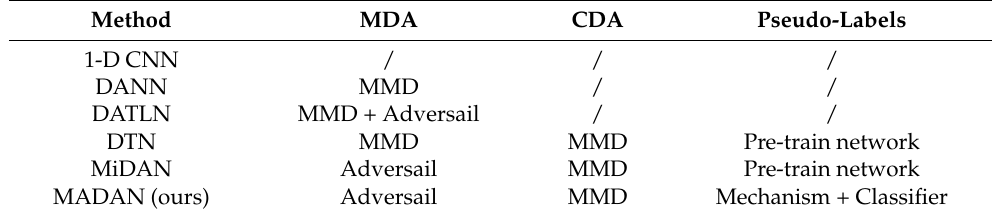
Table 4. Detailed description of the compared methods.